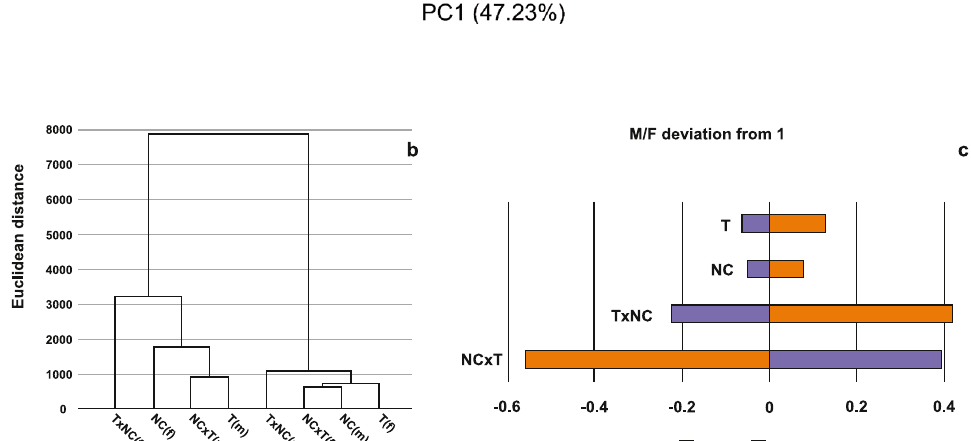
content was the least determinant of variation between individuals (the shortest vector), which was confirmed using the Tukey test to compare the means. Plants showing the highest DPPH values were spaced from the remaining forms. The T × NC males were closer to NC × T females than to the T × NC females, which occupied the most distant position. The Ward’s hierarchical analysis based on the original dataset showed two clearly distinct clusters composed of four plants each; a higher similarity between individuals was observed in the right one (Fig. 4b). The genders and forms were mixed up, and the only regularity was separation of the sexes belonging to a given form between these clusters. In the left cluster the greatest similarity was recorded for the NC × T and the T males (different cytoplasm, the same Y chromosome), in the right cluster—the NC × T females and NC males (same cytoplasm, different sex chromosomes). In each cluster, the T × NC hybrid occupied a separate position.